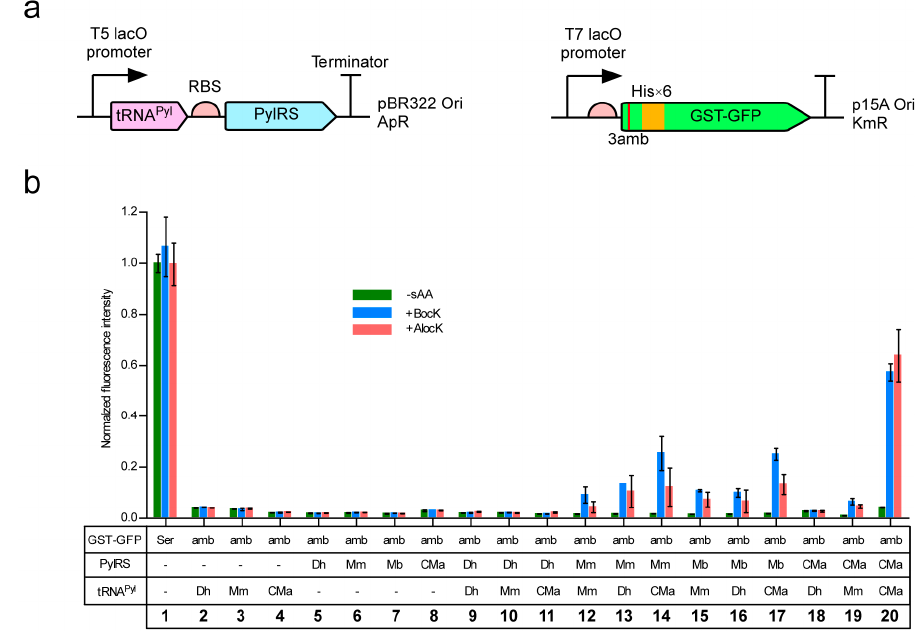
Figure 1. ( a ) Expression systems for PylRS, tRNA Pyl , and the GST-GFP reporter gene. “RBS”, “ApR”, and “KmR” represents the ribosome binding site, the ampicillin resistance, and the kanamycin resistance, respectively. ( b ) Cell-based fluorescence with the indicated combinations of PylRS and tRNA Pyl relative to the average intensity for the “Ser” GST-GFP. “ − sAA” represents the absence of BocLys (BocK) and AlocLys (AlocK). Three independent measurements were performed. The error bars indicate standard deviations.